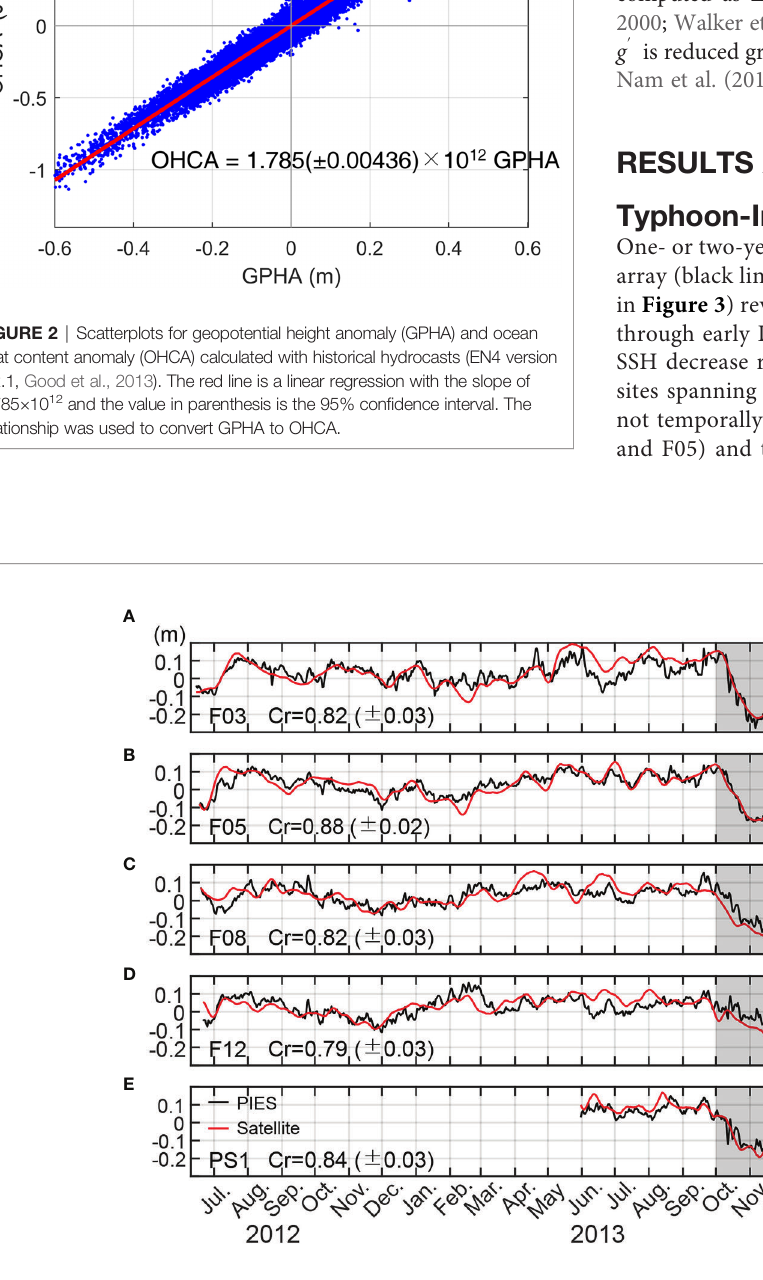
FIGURE 3 | Comparison of sea-surface height (SSH) anomalies from pressure-recording inverted echo sounder (PIES; black) and satellite altimetry (red) at (A) F03, (B) F05, (C) F08, (D) F12, and (E) PS1. Ocean heat content (OHC; J m – 2 ) anomalies converted from PIES-derived and satellite-measured SSH are marked on the right y-axis (see text for details). The dark shaded period is the timing at which typhoon-enhanced cold eddy passes through the PIES sites. The mooring site names and correlation coef fi cients with 95% con fi dence interval between PIES-derived and satellite-measured SSHs (Cr) are described on the left of each